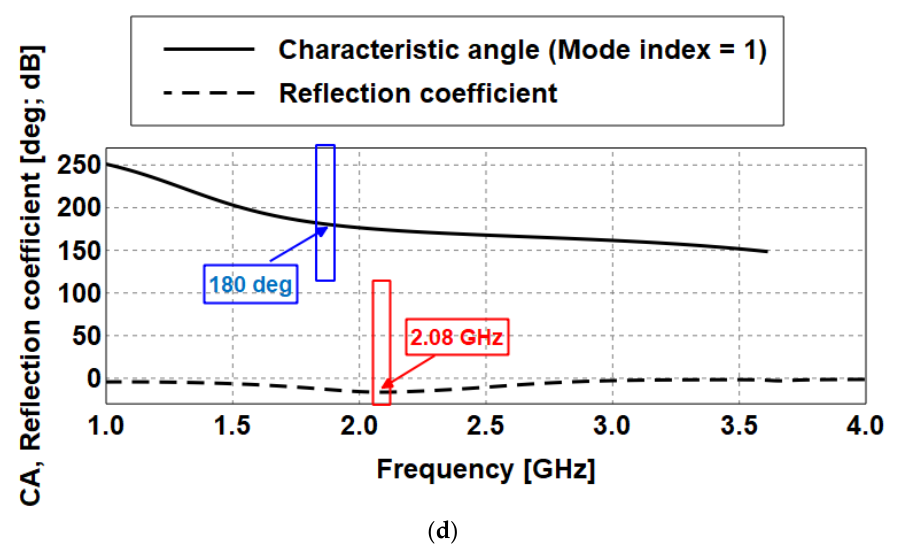
Figure 9. Characteristic angle and reflection coefficient of the patch with PRSs on different substrates: ( a ) Felt ( b ) Denim ( c ) RO4003C ( d ) Rogers 5880. Table 7. Overall Results of CRS and PRSs Antennas.